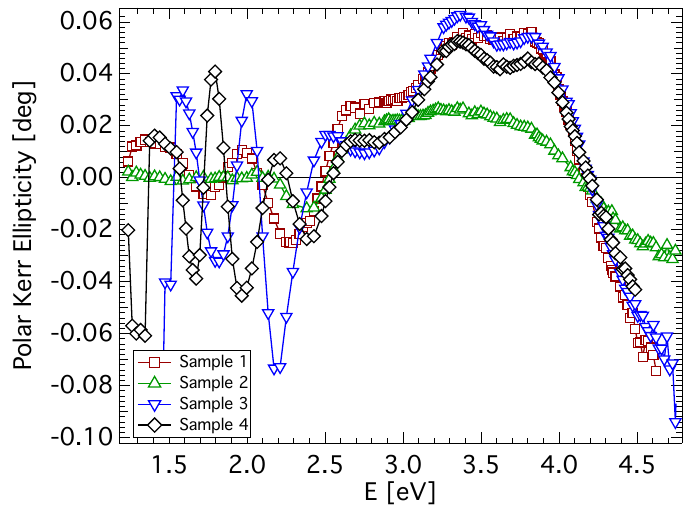
Figure 3. Polar Kerr ellipticity spectra of CuFe normal